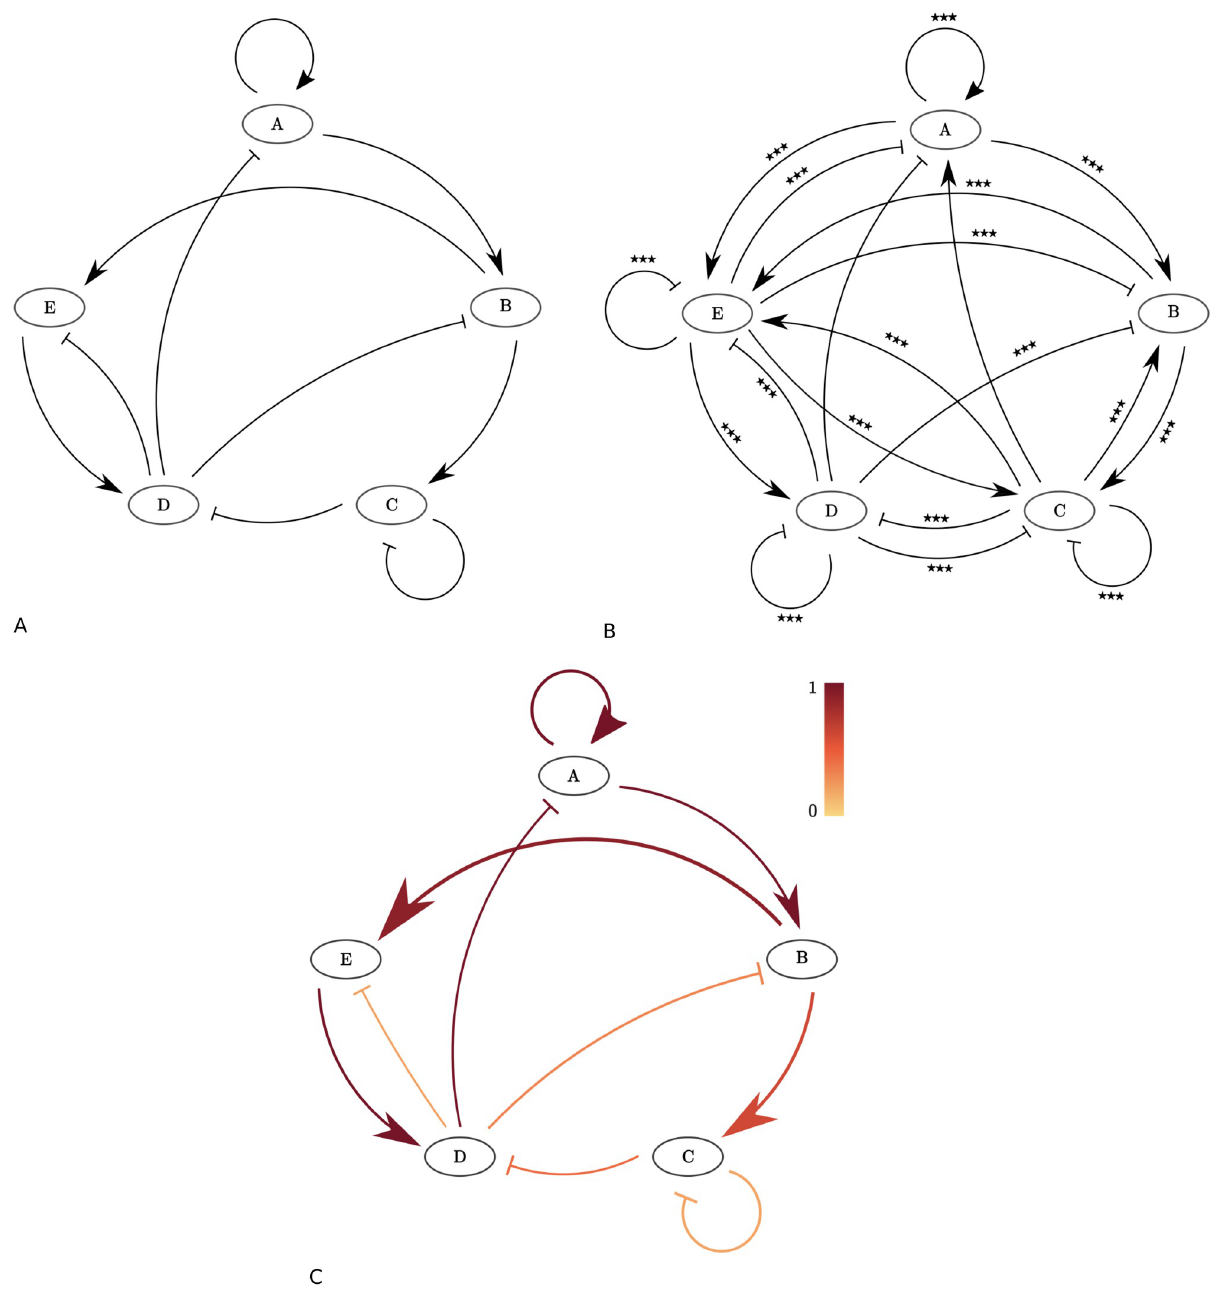
Fig 7. The validation test model consisting of five cytokines and ten edges. A: The test model. To construct this model configuration, we included the four network motifs we considered before (eight edges, Fig 5), and added two self-edges. B: Network extracted using statistical analysis from the example synthetic data set (Section “Validation”). Two sample t-test: $$$ p � 0.001, fdr corrected. Ten of the shown edges are part of the test model and were used to generate the synthetic dataset. The other edges are spurious. C: The ten-edge network configuration selected by the AIC, applied to our example synthetic dataset. Edge widths are proportional to the value of the corresponding edge parameter α shown network configuration. Edges are coloured proportional to the increase in D when they are removed from the shown network configuration.